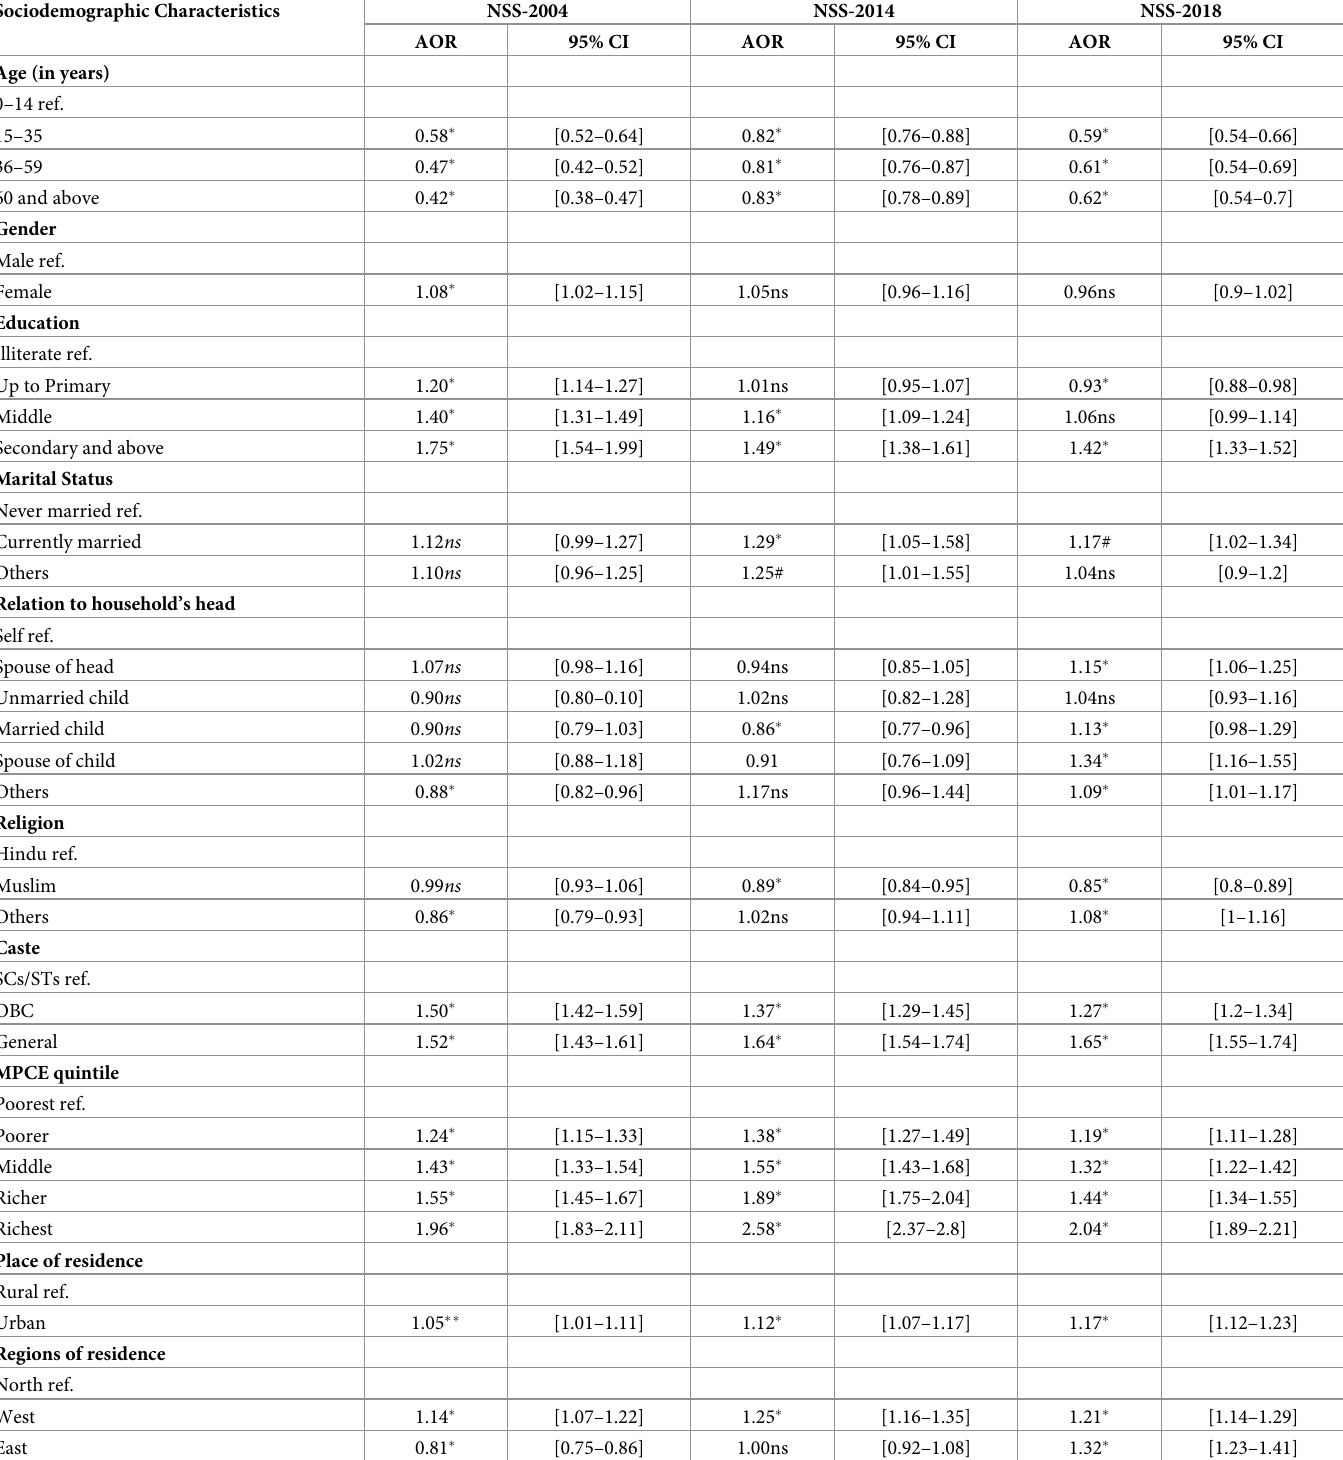
Table 4. Adjusted odds ratios obtained from logistic regression analysis to examine effects of Sociodemographic characteristics on unmet need for treatment-seek- ing from public health facilities, India, NSS, 2004–2018. Sociodemographic